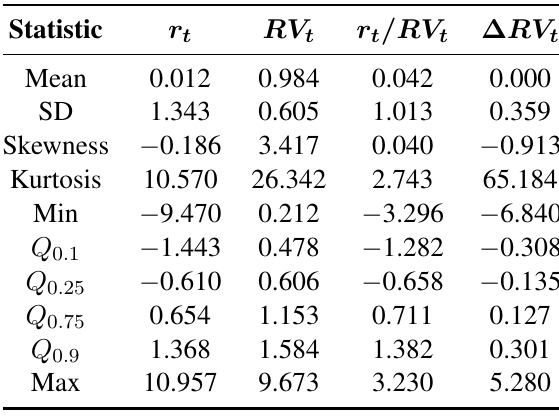
Table 3. Descriptive statistics: S&P